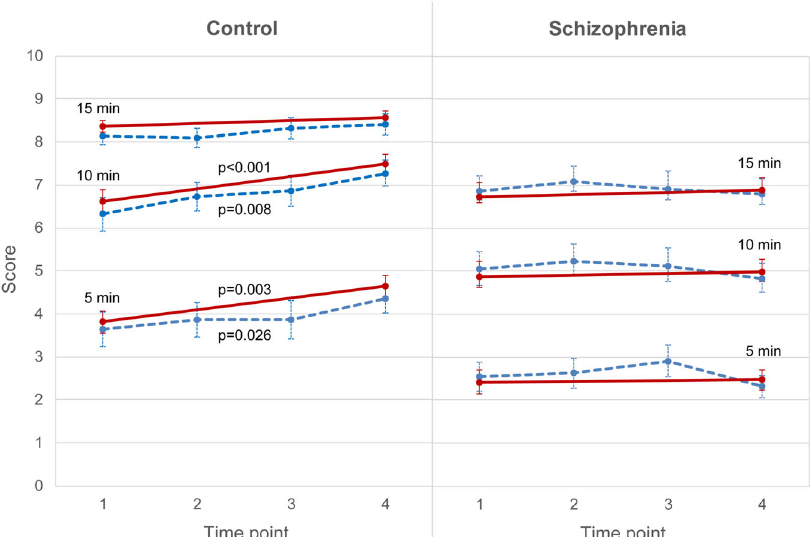
Fig. 1 Longitudinal pattern of niacin-induced fl ush. Mean niacin fl ush score that was summed over the three concentrations for ratings at 5, 10, and 15 min, respectively, at different time points in a healthy controls and b schizophrenia patients, with error bars representing standard error. Time 1 = baseline, time 2 = week 2, time 3 = week 4, and time 4 = week 8 or on the fi rst outpatient follow-up if the patient had been discharged by 8 weeks. Solid lines represent the scores of all participants who had fl ush scores at both time 1 and time 4 ( n = 37 for controls and 46 for schizophrenia) and dashed lines the scores of a subgroup of participants who had fl ush scores at all four time points ( n = 22 for controls and 35 for schizophrenia). For those summed niacin fl ush scores that changed signi fi cantly with time in a mixed-effects model were denoted with p